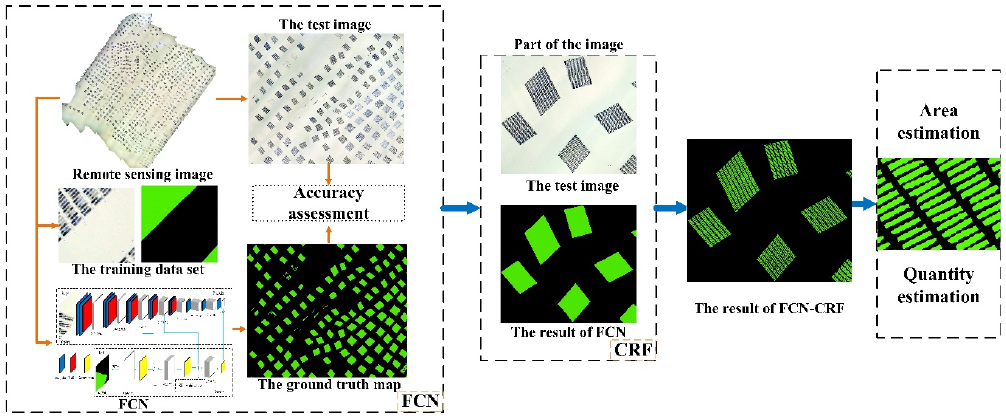
Figure 4. Overall flow chart of the experiment. FCN (Fully convolutional neural network); CRF (Conditional random filed).